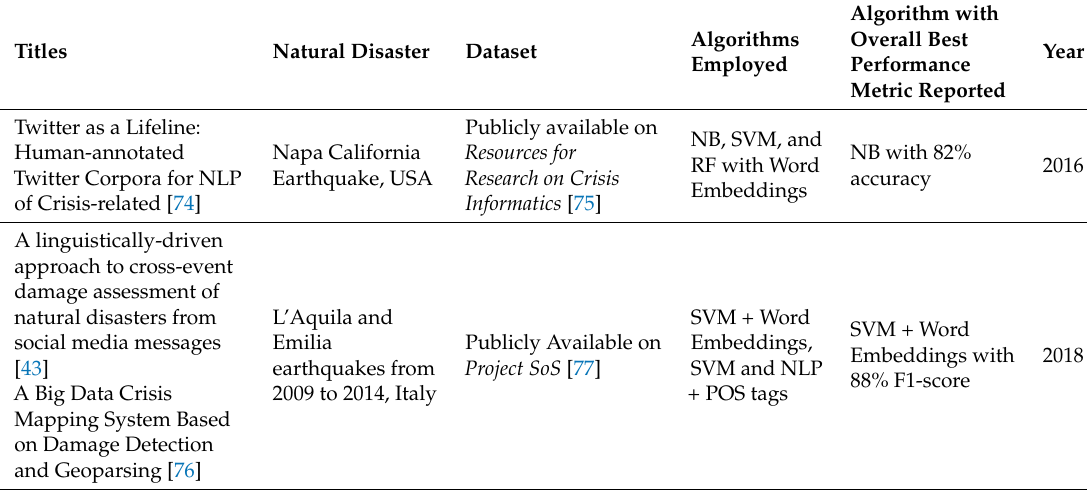
Table 6. Recent works used to compare the proposed